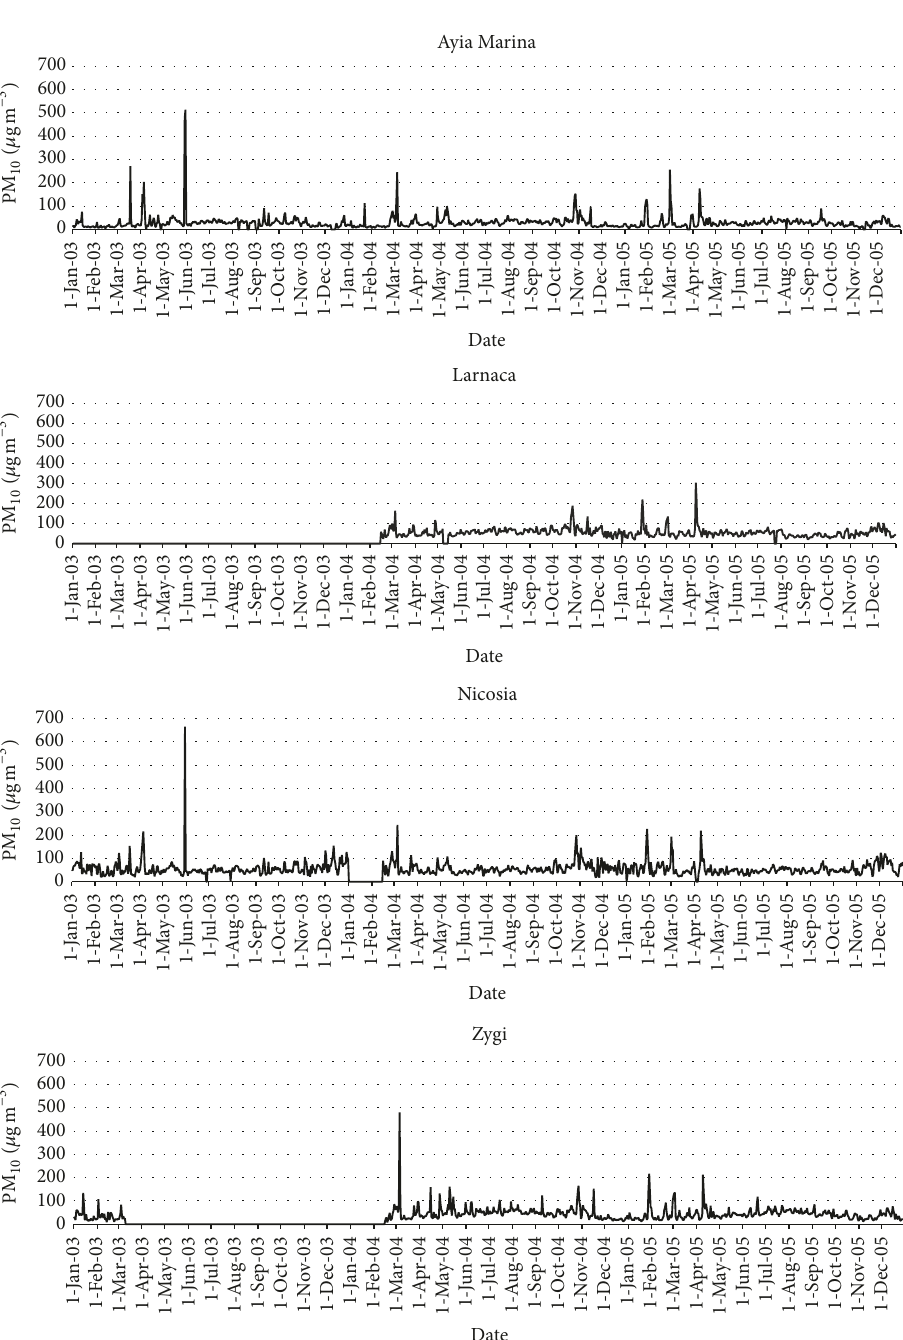
Figure 2: Time series of the average daily values of PM 10 concentrations for each of the four measuring stations (gaps in the time series are shown as